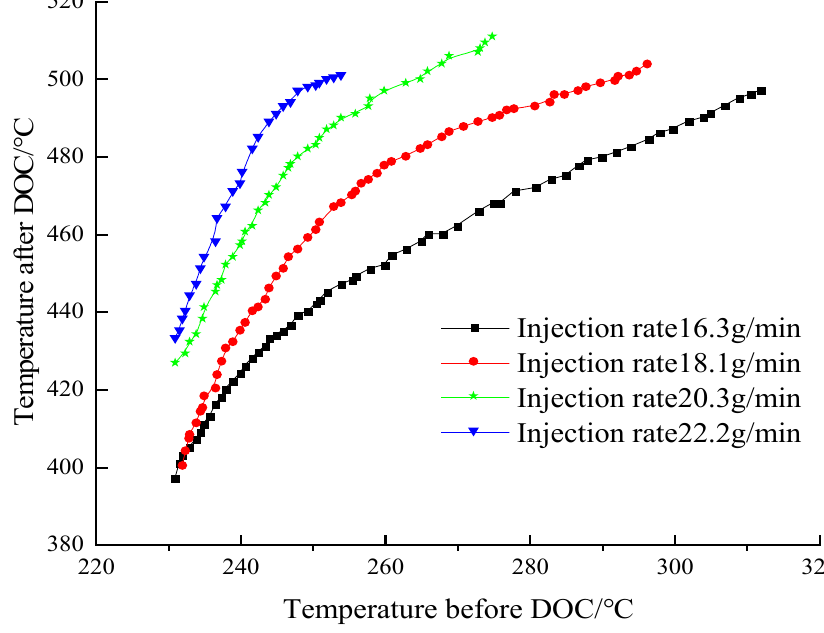
Figure 5. Diesel fuel injection rate corresponding to the temperature variation before and after DOC.